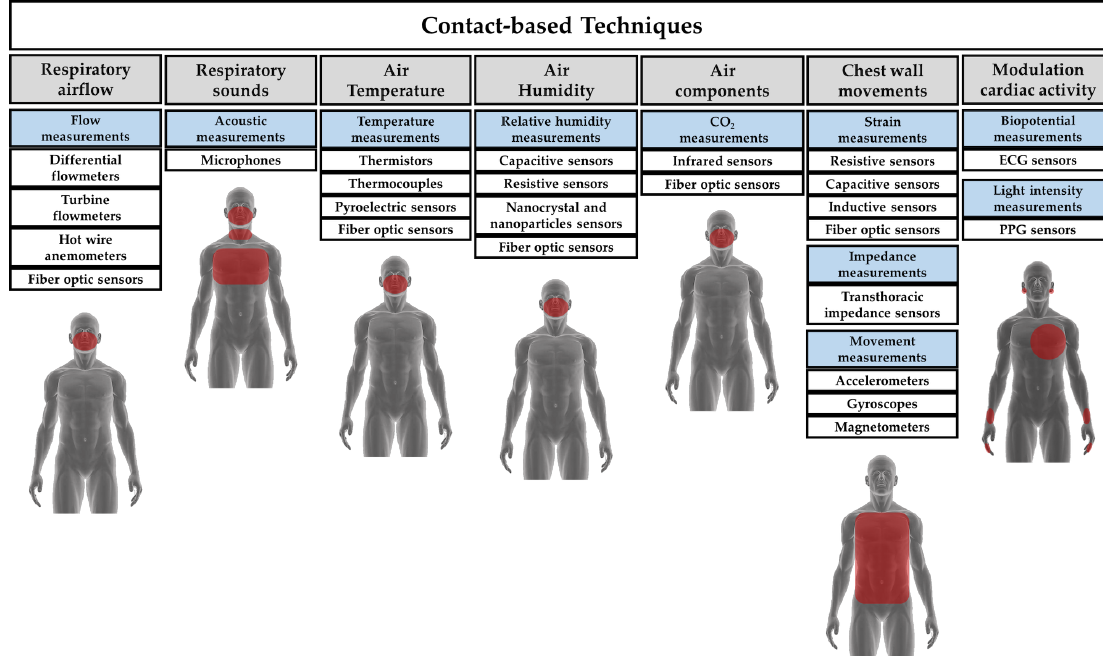
Figure 1. Most popular contact-based techniques for measuring f R and related areas of the body on which the sensors must be positioned. PPG = photoplethysmography; ECG =